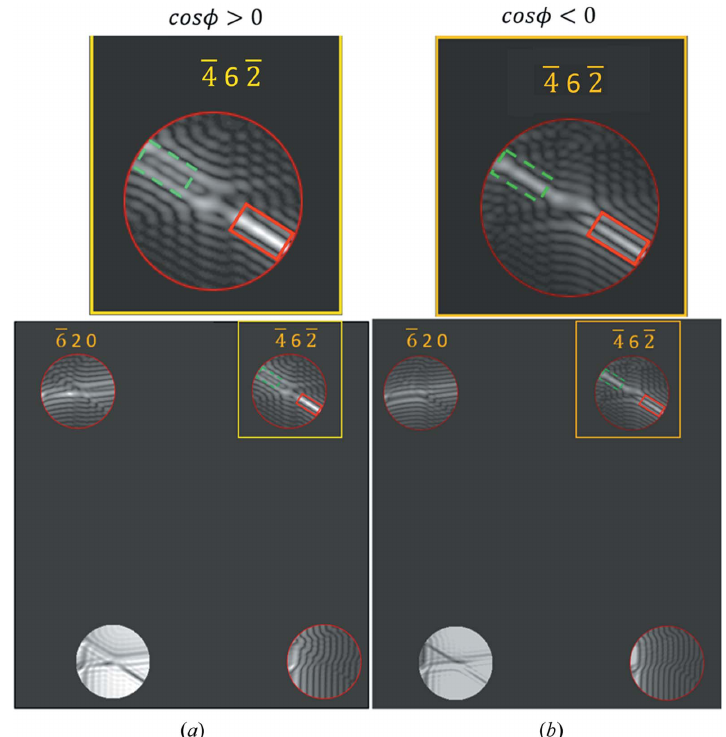
Figure 6 Illustrations of Criterion 6 for determining the sign of cos (cid:2) for thick specimens. The examples are simulated CBED patterns from ZnS [137] near a three-beam condition which is located in the centre of each disc. Following the convention in Fig. 1, the regions with negative and positive (cid:5) h are labelled with equally sized rectangles with dashed (green) and solid (red), respectively. In order to facilitate an inspection, the rectangles are located away from the exact three-beam condition by the same distance. In the simulations, the following values of the three-phase invariant and the thickness were used: ( a ) (cid:2) = 2.5 (cid:3) , z = 1720 A˚ ; ( b ) (cid:2) = (cid:4) 140 (cid:3) , z = 1980 A˚ . In the calculation of ( a ), the three-phase invariant was adopted from the structure itself whereas in the calculations of ( b ), the three-phase invariant was artificially adjusted in order to produce a situation such that cos (cid:2) < 0. The same adjustment as in Fig. 5 has been performed.